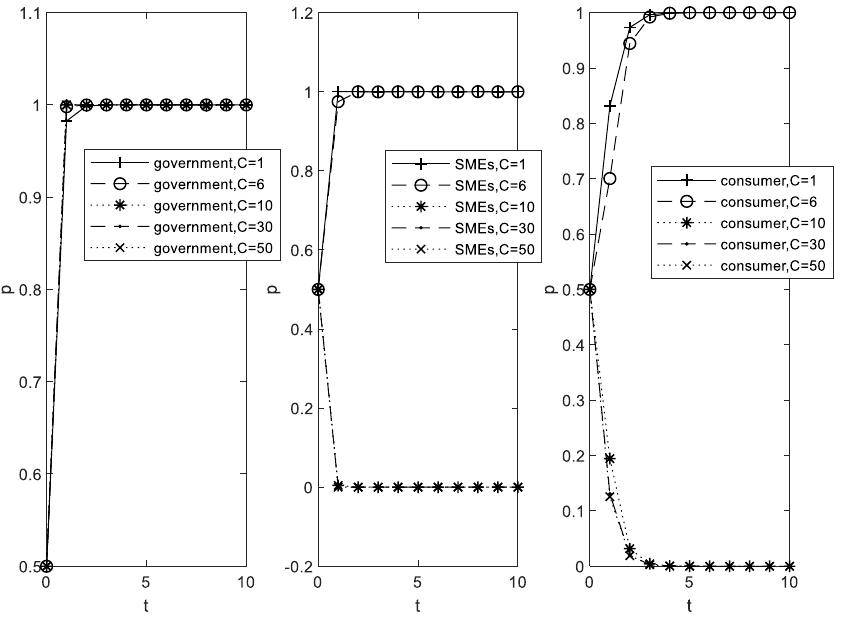
Figure 15. The impact of incremental cost ∆ C 2 on system evolution.